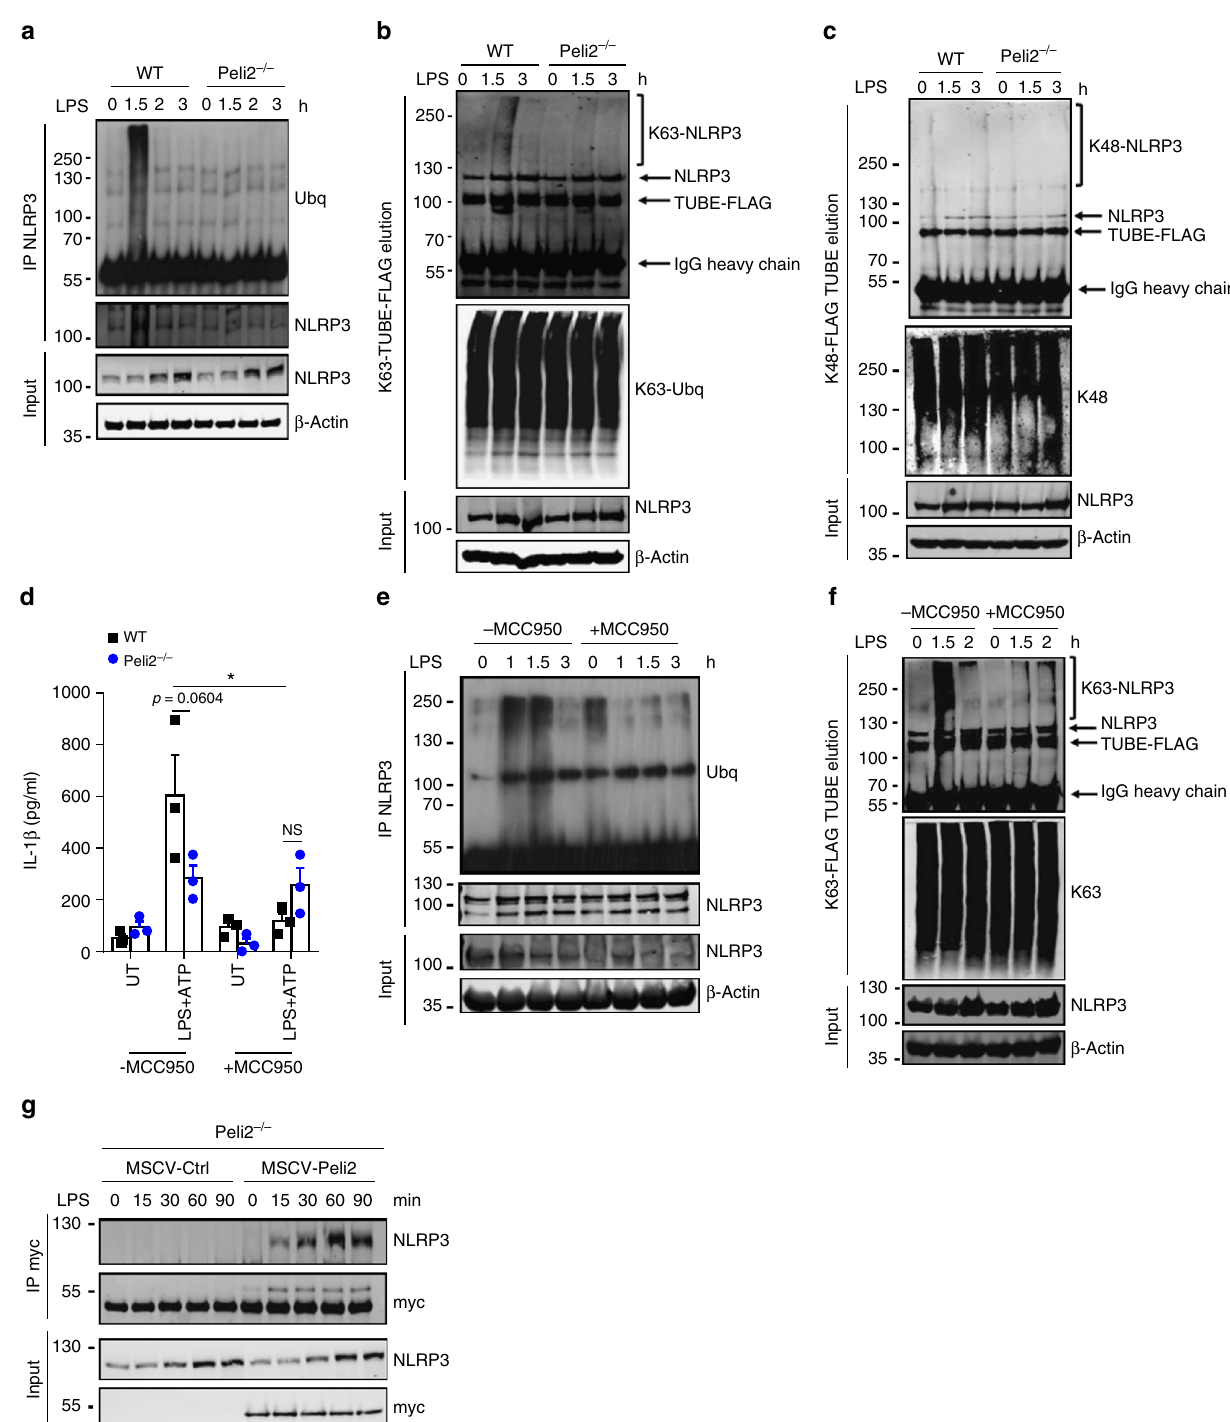
Fig. 7 Pellino2 mediates LPS-induced ubiquitination and activation of NLRP3. a-c Immunoblot analysis of NLRP3 and ubiquitin in cell lysates (Input) and immunoprecipitated (IP) NLRP3 samples ( a ) or NLRP3 and K63-linked ubiquitin (K63-ubq) in K63-TUBE-FLAG elution and cell lysates ( b ) or NLRP3 and K48-ubq in K48-TUBE-FLAG elution and cell lysates ( c ) from WT and Peli2 − / − BMDMs treated with a 100 ng/ml LPS for the indicated times. d ELISA of IL-1 β in medium from WT and Peli2 − / − BMDMs treated with 100 ng/ml LPS for 2 h followed by sequential treatment with 1 μ M MCC950 for 1 h and 2.5 mM ATP for 30 min. UT, untreated. e, f Immunoblot analysis of ubiquitin and NLRP3 in lysates (Input) and immunoprecipitated (IP) NLRP3 samples ( e ) or NLRP3 and K63-ubq in K63-TUBE-FLAG elution and cell lysates ( f ) from WT and Peli2 − / − BMDMs pre-treated with 1 μ M MCC950 for 1 h followed by treatment with 100 ng/ml LPS for the indicated times. g Peli2 − / − BMDMs were infected with MSCV as control (MSCV-Ctrl) or with MSCV containing